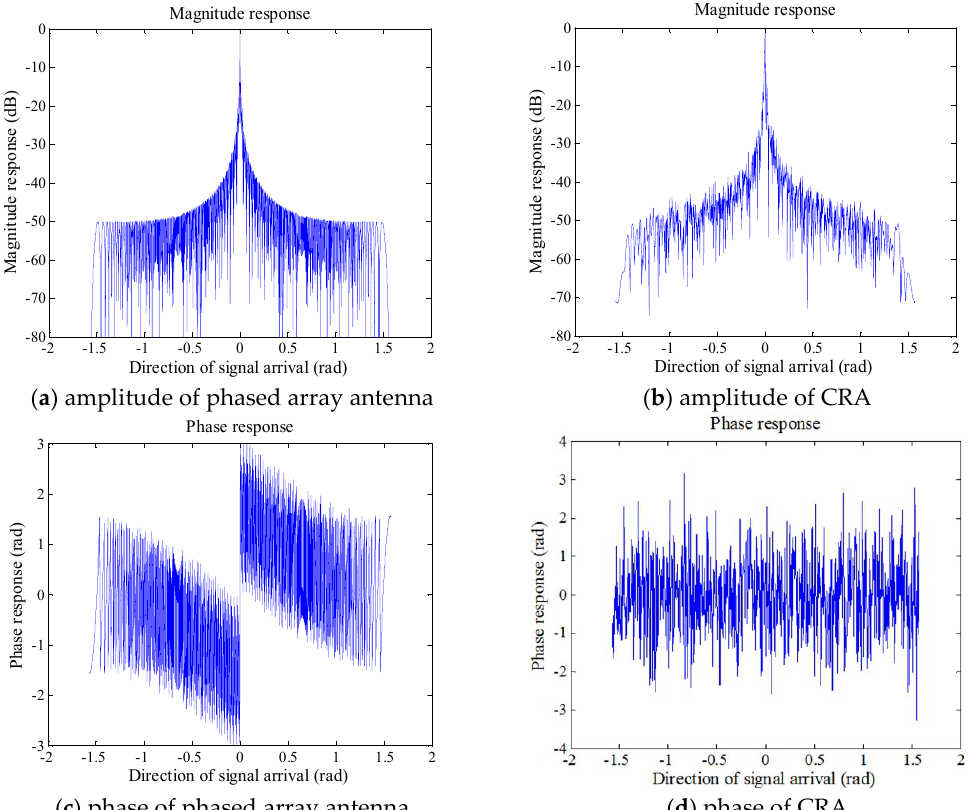
Figure 5. The amplitude and phase patterns of the phased array antenna and compressive reflector antenna (CRA), compared with the linear phase of the phased array antenna; the phase of the CRA is random.